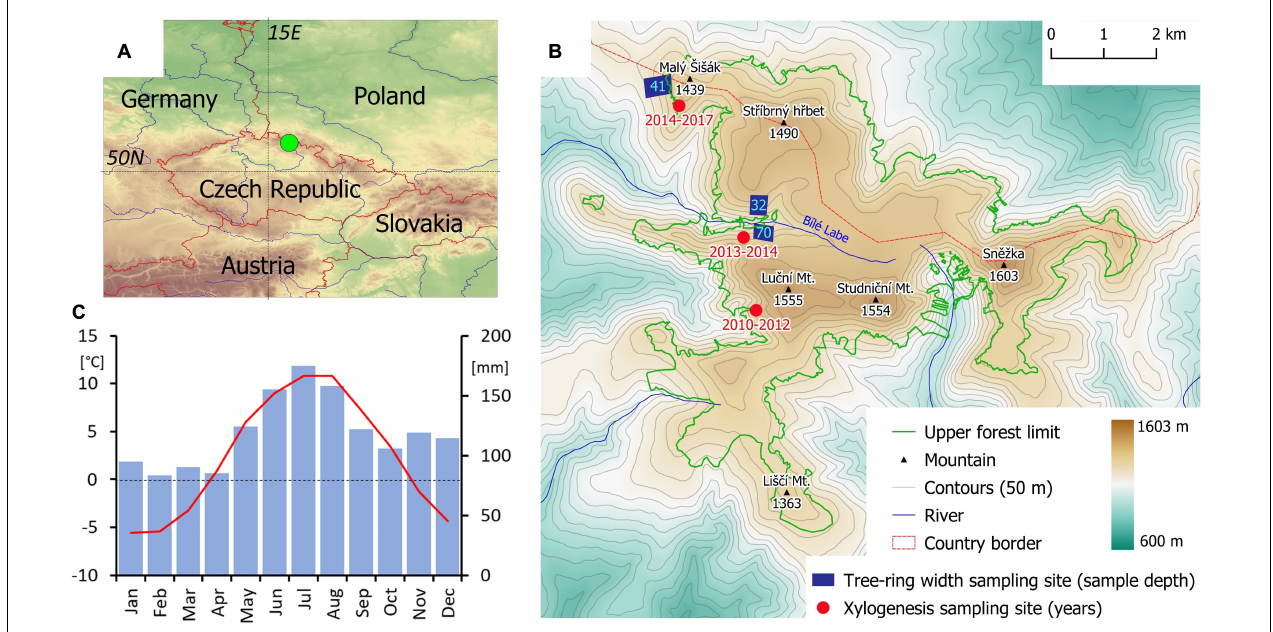
FIGURE 1 | Location of the study area in the Central Europe (A) ; distribution of individual tree-ring width and xylogenesis sampling sites in local treeline ecotone (B) ; and monthly temperature means (red) and precipitation sums (blue) (C) . Position of upper forest limit (lower boundary of treeline ecotone) according to Treml and Migo´n